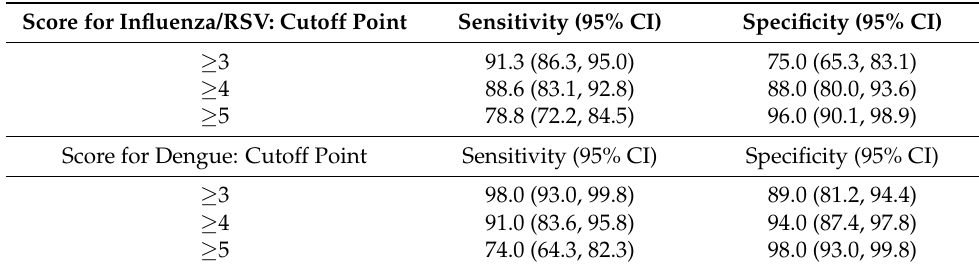
Table 8. Sensitivity and specificity of different cutoff points for differentiating between influenza/RSV or dengue and